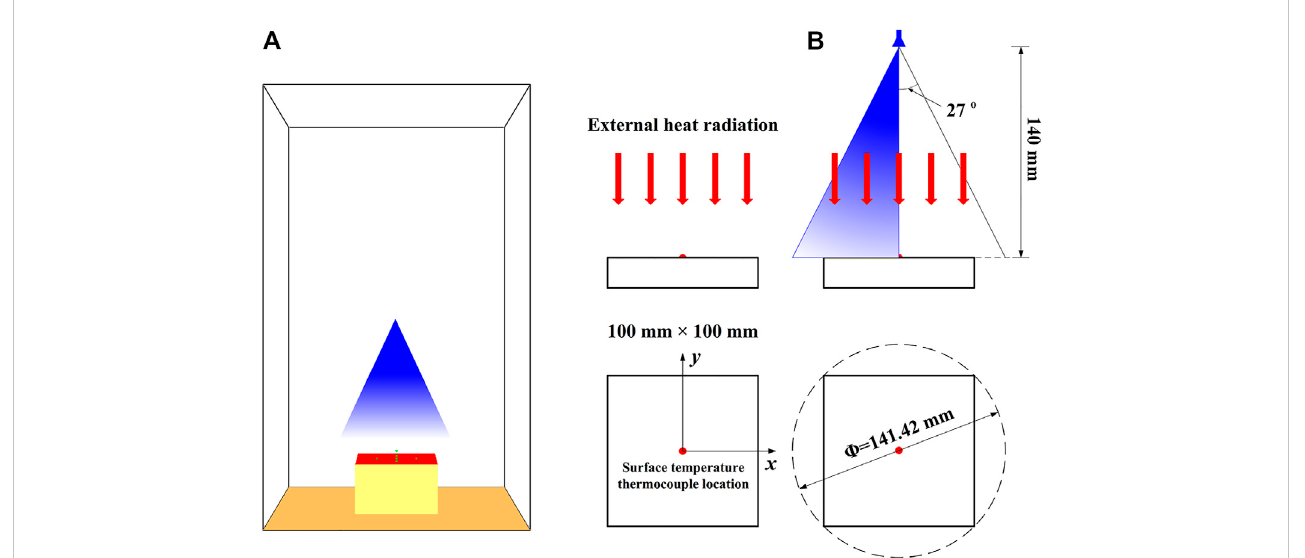
FIGURE 1 Schematic diagram of numerical model [ (A) : simulation scene; (B) : size description].